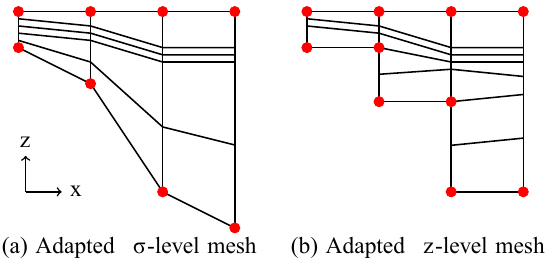
Figure 4. Comparison between an adapted σ -level mesh (a) and an adapted z -level mesh (b) . The nodes marked with a red dot are fixed during the mesh vertical diffusion process, which is independent of the movement necessary to accommodate to the motion of the free surface (Eq. 19).